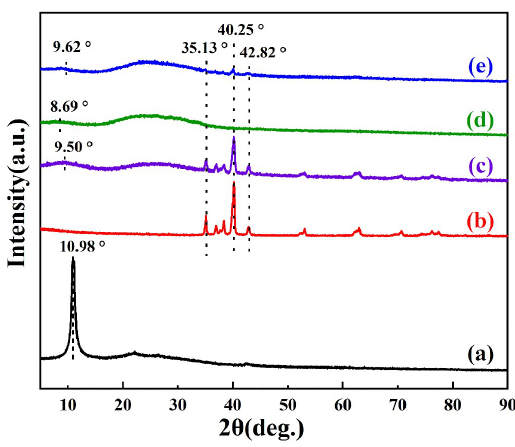
Figure 5. XRD pattern of ( a ) GO, ( b ) Ti, ( c ) GO-Ti (1:1), ( d ) GO-Ti (2:1), and ( e ) GO-Ti (3:1) composites.